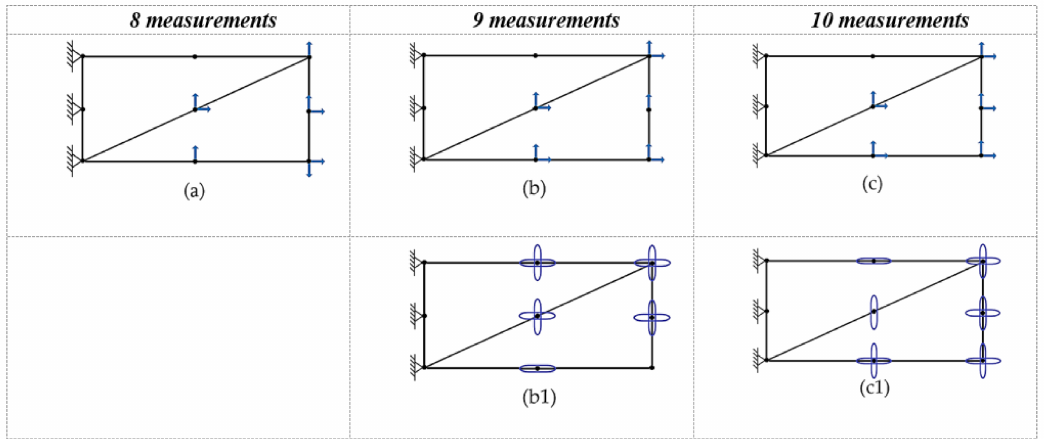
Figure 5. Required number of measurements for having the partial ( a , b , c ) and full observability ( b1 , c1 ) of the